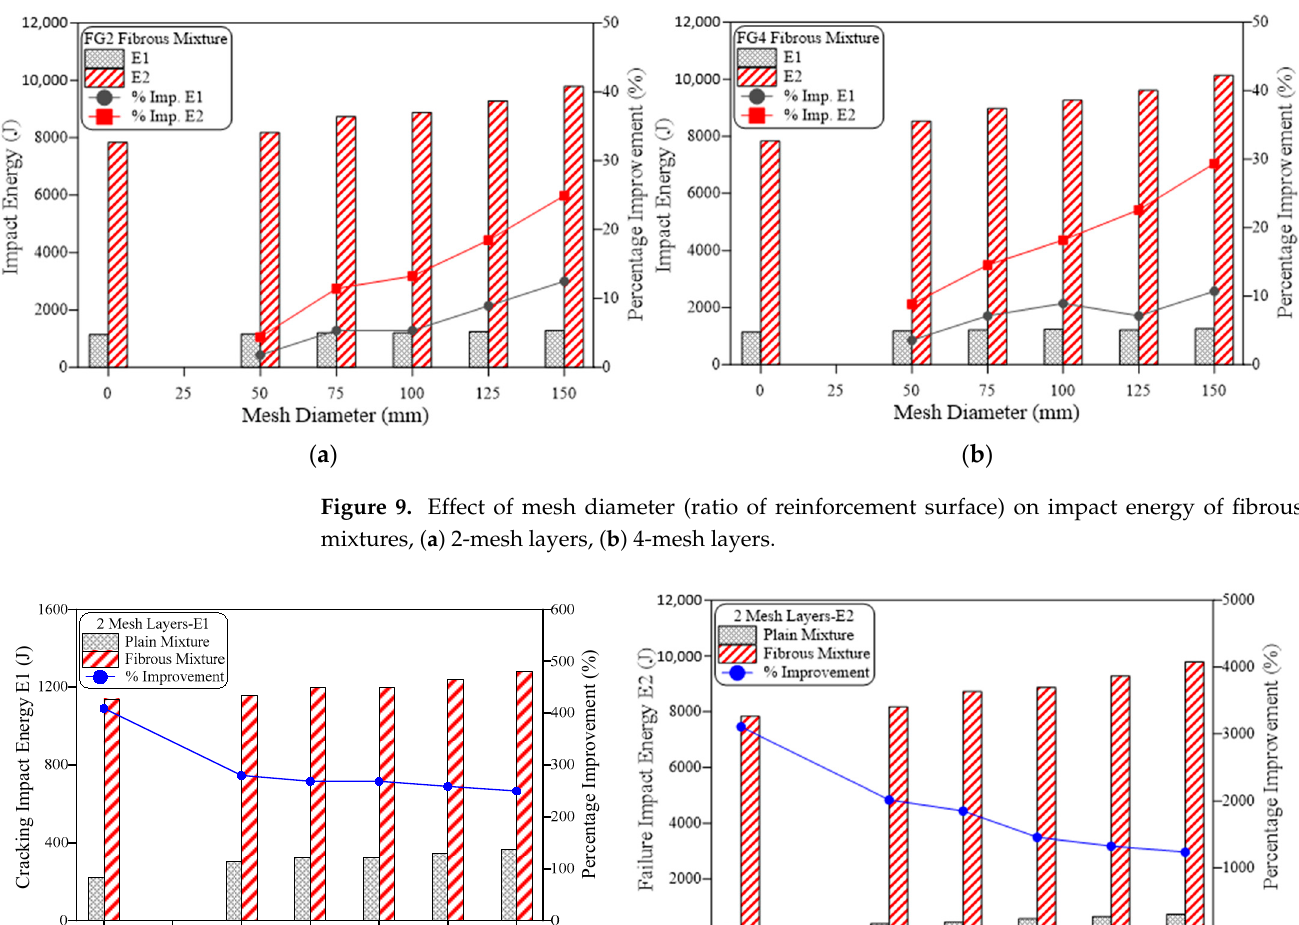
Figure 8. Effect of mesh diameter (ratio of reinforcement surface) on impact energy of plain mix- tures, ( a ) 2-mesh layers, ( b ) 4-mesh layers.